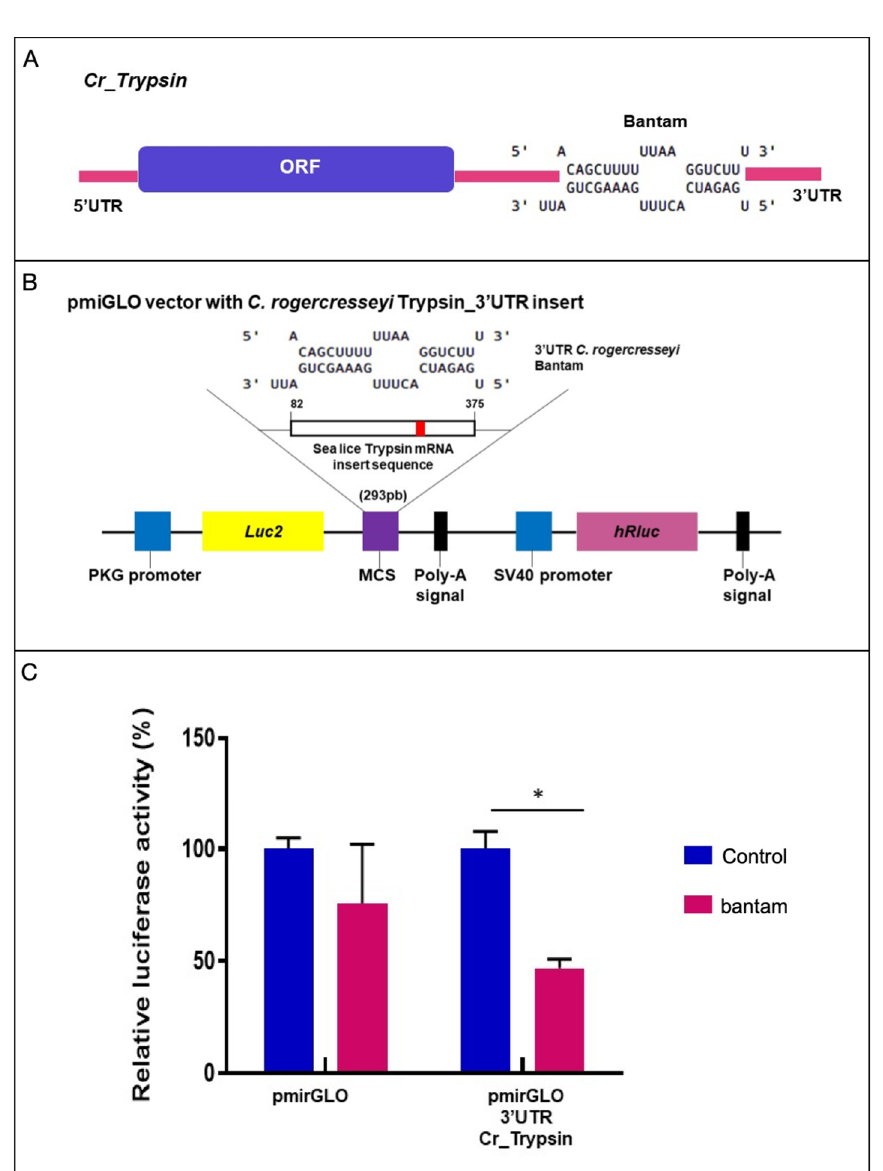
Figure 6. Validation of trypsin-2 target site for bantam miRNA. ( A ) The predicted binding site for bantam in 3 ′ UTR of trypsin-2 gene. ( B ) Schematic representation of pmirGLO-3 ′ UTR trypsin vector construction. ( C ) Luciferase assay showing luminescence activity after exposure of pmirGLO-3 ′ UTR trypsin vector to bantam mimic sequence. The asterisk indicates significant differences ( p < 0.001). Control samples correspond to the vector without the trypsin-2 gene insert.